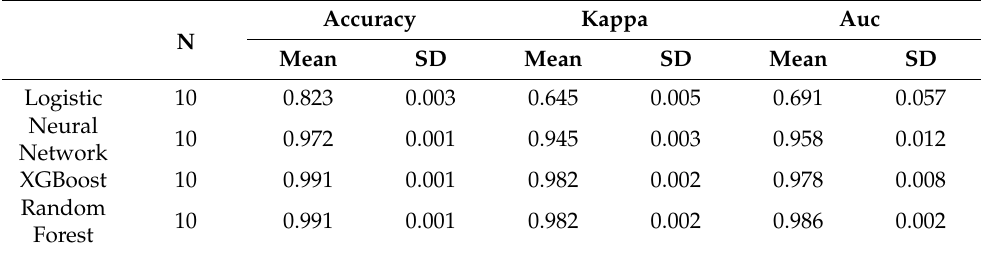
Table 3. The prediction performance of validation data of balance